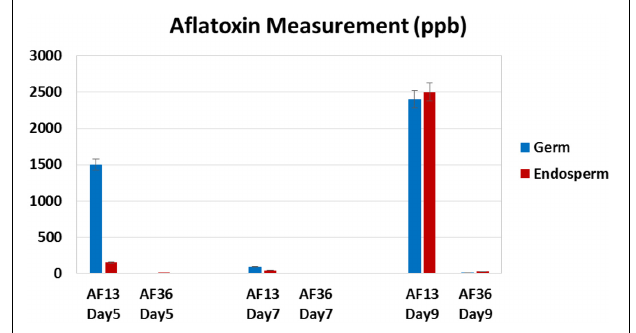
FIGURE 6 | Aflatoxin content (parts per billion, ppb) of maize kernel components (germ and endosperm) inoculated with toxigenic (AF 13) and atoxigenic (AF 36) A. flavus at three time points over a 9 day period (Days 5, 7, and 9). Error bars represent ±